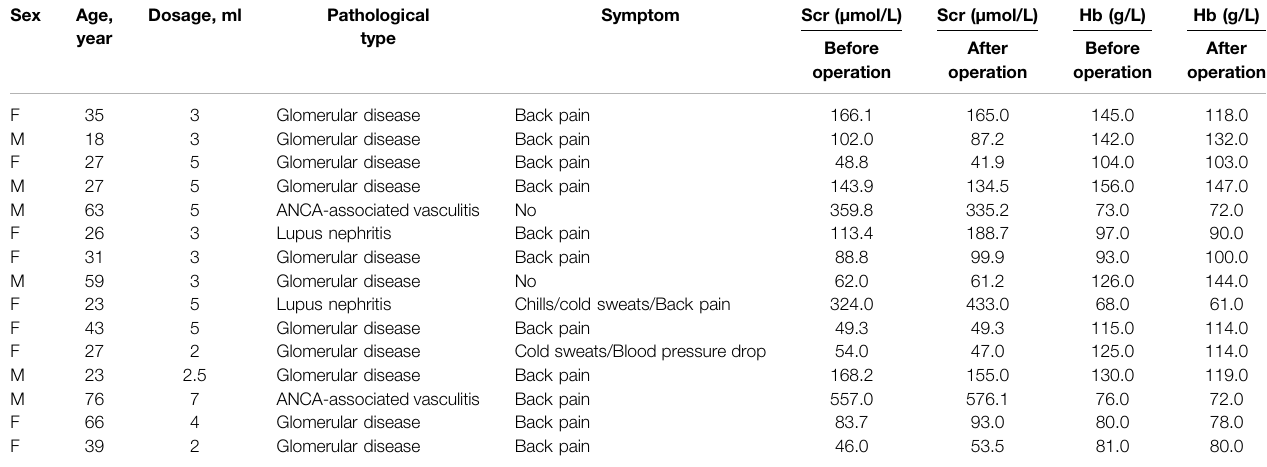
TABLE 1 | Clinicopathological data of the patients, n (cid:1) 15. Sex Age,